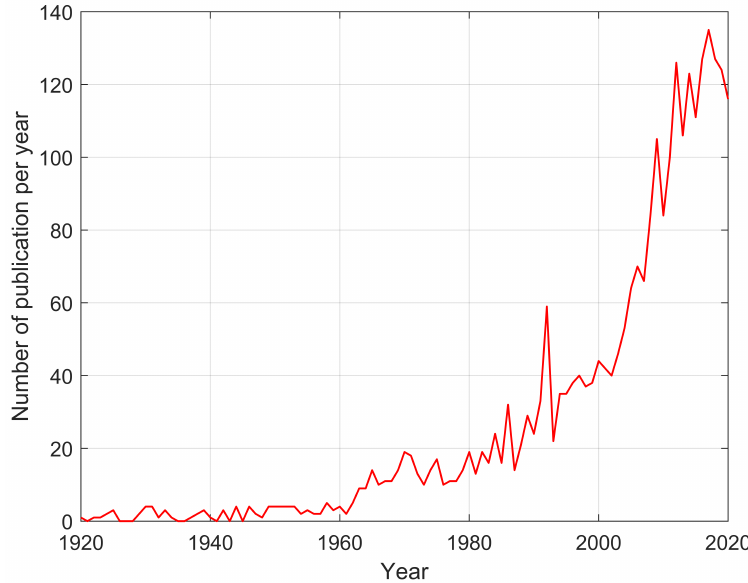
Figure 1. Number of publications released per year based on a selected combination of